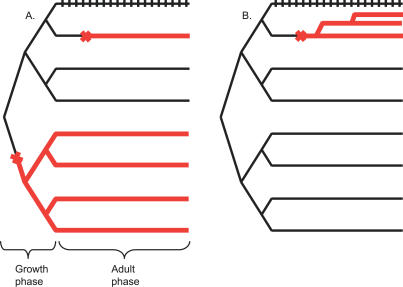
Model SchemesThe models are depicted with only three growth phase generations leading to eight adult SrAp cells; in actuality there are ∼30 growth phase generations leading to ∼1010 adult SrAp cells. The vertical tick marks across the top line depict adult phase generations; for the donors in this paper there are ∼1,000 adult phase generations. (A) Mutation hot spot model (p = 0). There are two mutation events (red crosses): one is in the adult phase which produces one mutated SrAp cell, while the other one in the growth phase produces four mutated SrAp cells. (B) Selection model (p > 0). The one mutation in the adult phase now produces three mutated SrAp cells.